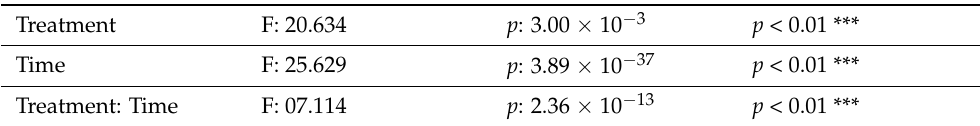
Table 4. Results of repeated measures ANOVA of species richness. Asteriks indicate statistical